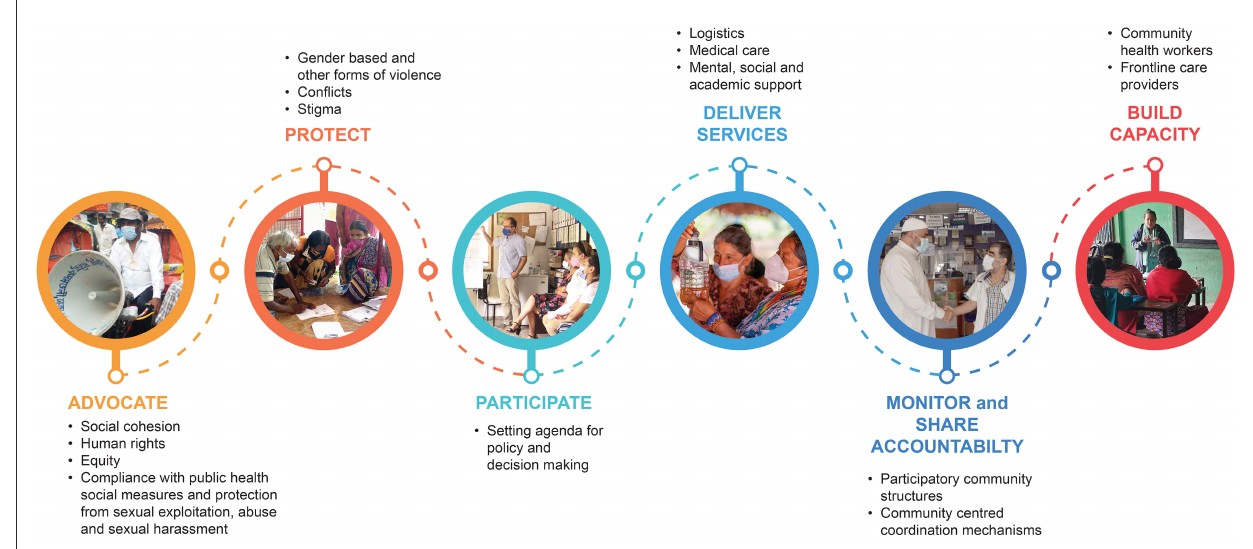
FIGURE4 Civil society organizations’ roles in mitigating COVID-19 impact at the community level (graphic Nellie Kartoglu/WHO).